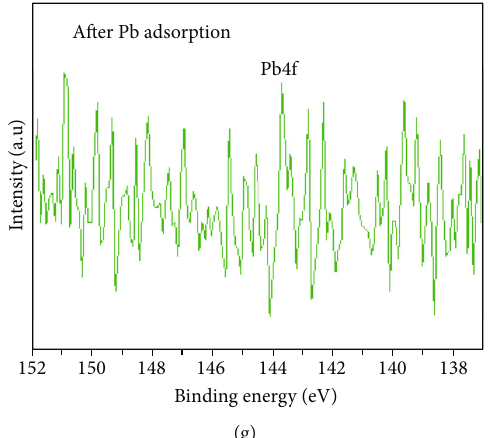
Figure 11: (a) XPS characterization before and after microplastics adsorption of heavy metals, (b) C1s spectrum of the original PP, (c) O1s spectrum of the original PP, (d) microplastic adsorption of Cu 2+ , (e) microplastic adsorption of Cd 2+ , (f) microplastic adsorption of Zn 2+ , and (g) microplastic adsorption of Pb 2+ ( V = 20 mL, temperature at 298 K, t = 48